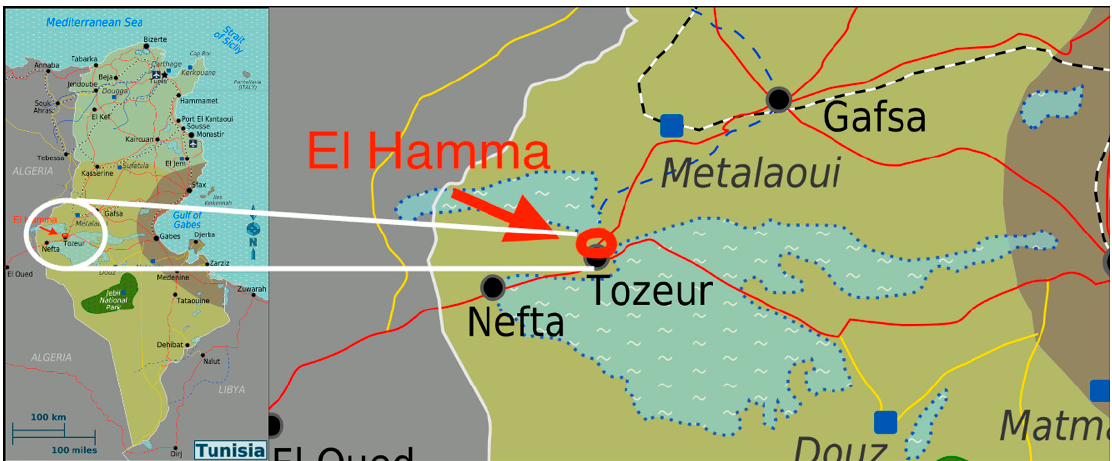
Figure 1. The oasis of El Hamma is located in the southwest of Tunisia in the governorate of Tozeur. According to the FAO agroecological classification, the oasis belongs to the warm/cold subtropical zone. Tozeur has a hot desert climate (Köppen climate classification BWh) typical of the northern edge of the Sahara Desert, with an average annual rainfall of 81.8 mm. Summers are extremely hot (temperature > 45 ◦ C), while in winter, it can sometimes freeze at night when temperatures drop below 0 ◦ C.